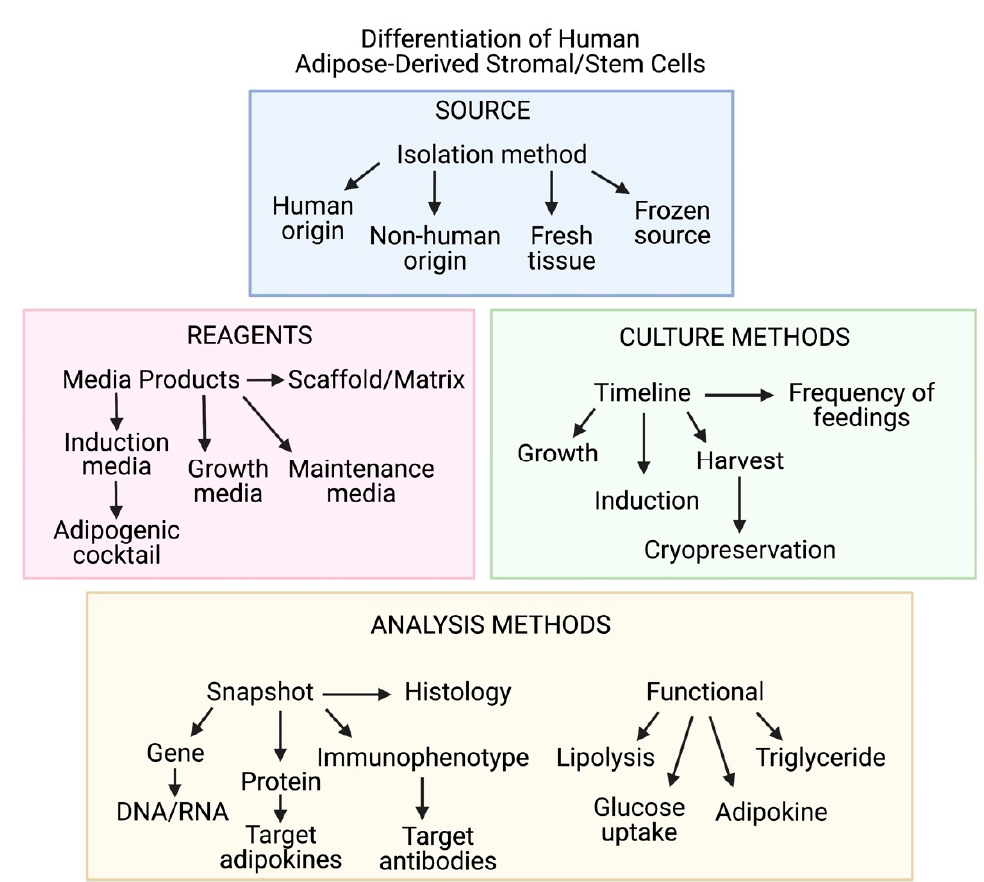
Figure 7. Diagram demonstrating critical variables associated with in vitro modeling of human adipose tissue. Imaged created with BioRender.com.